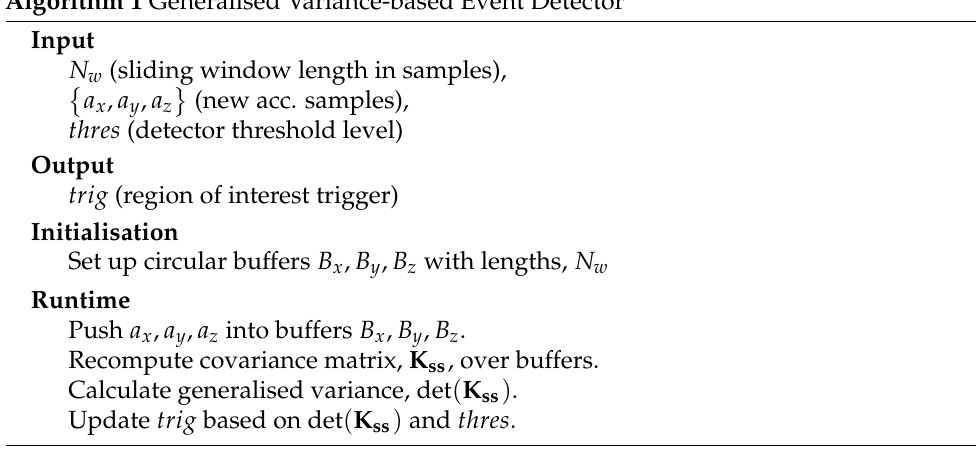
Algorithm 1 Generalised Variance-based Event